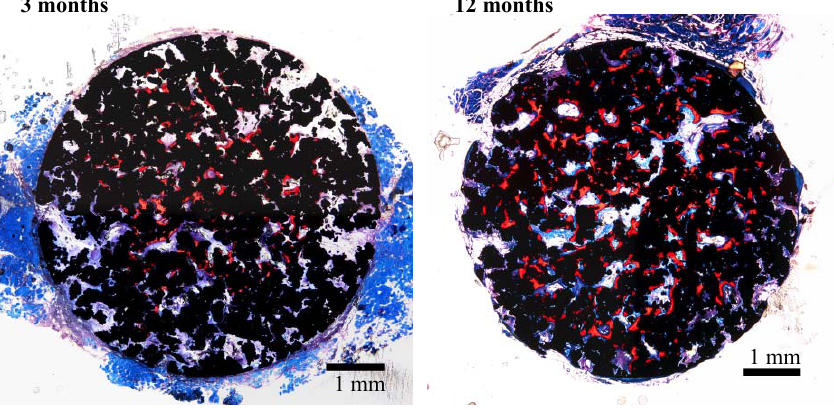
Figure 23. Fusion of spine of dog by a bioactive porous Ti metal. Reprinted from Ref. [21] with permission from American Association of Neurological